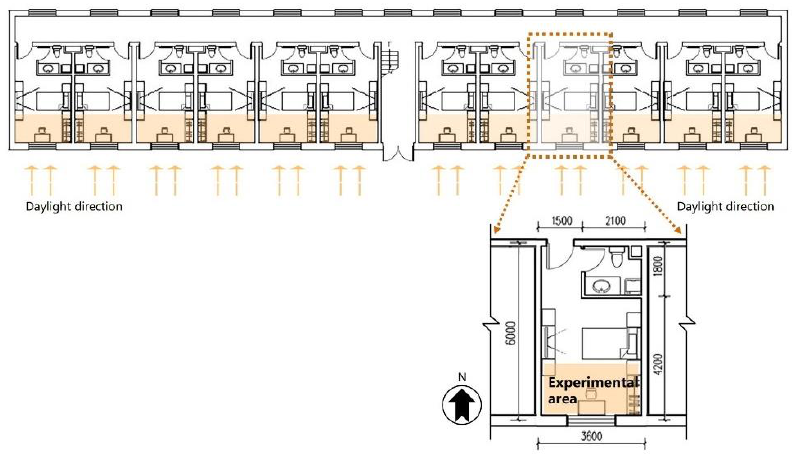
Figure 2. Floor orientation and room layout.